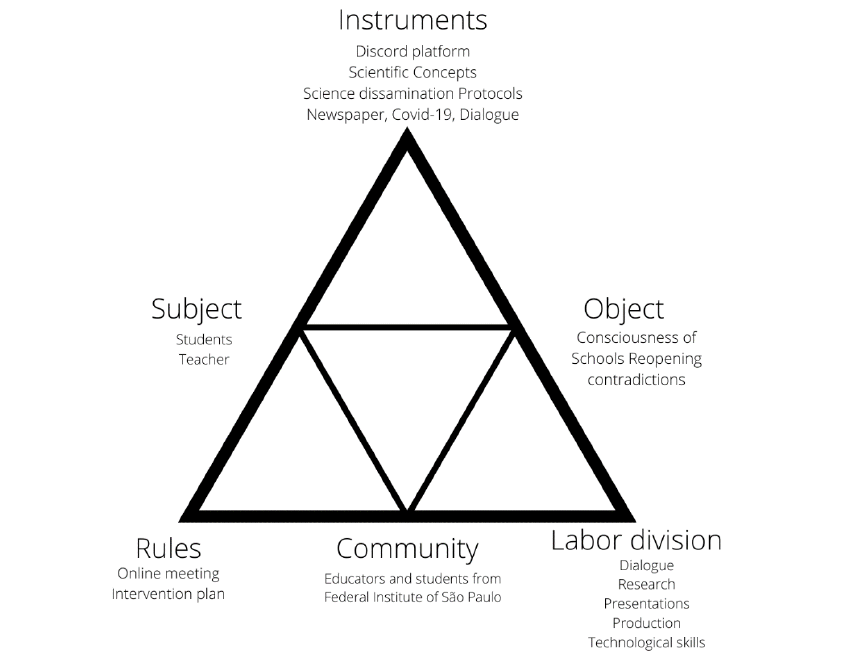
Figure 4: Arrangement of Dialogical activity on Discord.